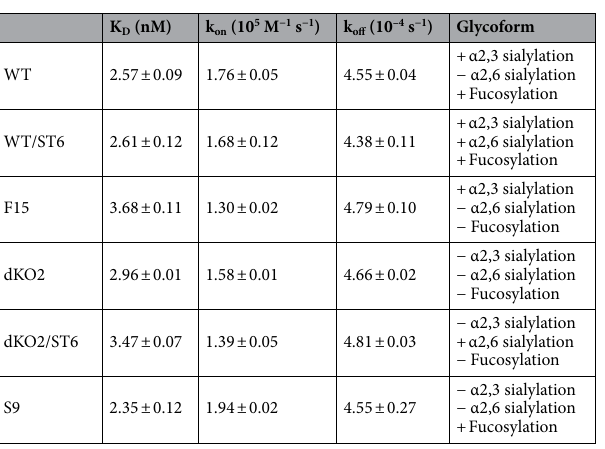
Table 4. Affinities of various ACE2 glycoforms for wild type RBD. + and − signs indicates the presence or absence of the glycosylation